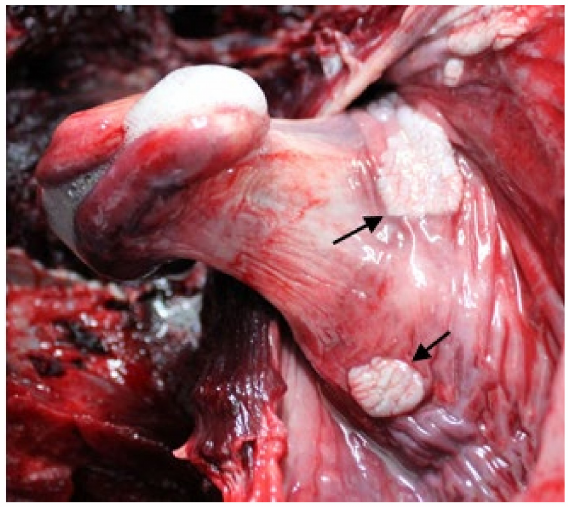
Figure 8. Risso’s dolphin, oropharynx, macroscopic image. Larynx with multifocal, discrete, raised, white plaques with rough surface